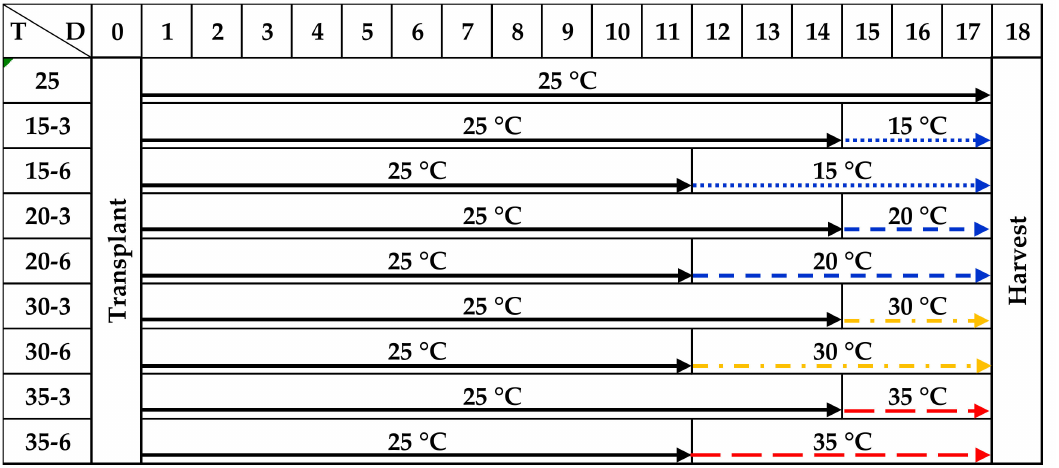
Figure 1. Root-zone temperature (RZT) regimes with di ff erent periods of temperature treatments during 18 days of cultivation. Treatment code ( T ): “25”, “15”, “20”, “30”, or “35” denotes an RZT of 25 ◦ C, 15 ◦ C, 20 ◦ C, 30 ◦ C, or 35 ◦ C, respectively; “3” or “6” denotes stress period of 3 or 6 days, respectively. D : day of